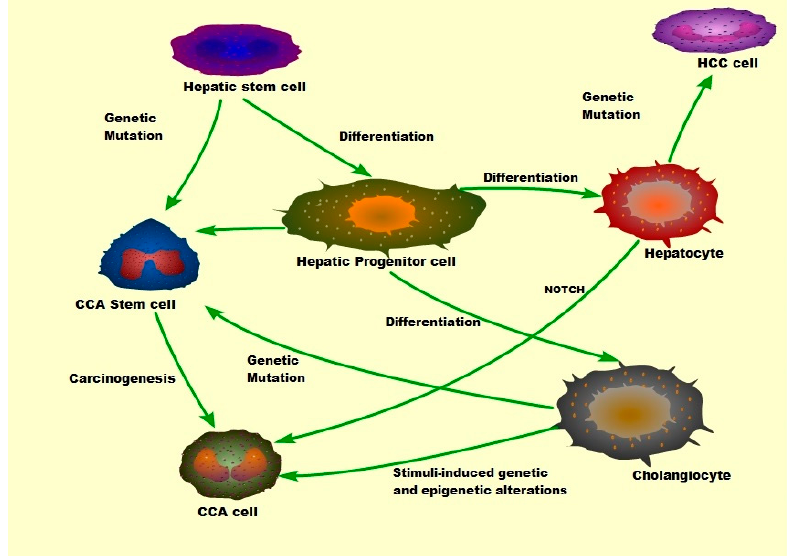
Figure 2. The hierarchy of cholangiocarcinoma stem cells . Hepatic stem cells grow and differentiate into hepatic progenitor cells and mature hepatocytes (hepatocytes and cholangiocytes). CCA stem cells are produced by genetic abnormalities of hepatic stem cells, hepatic progenitor cells, or CCA cells, which then grow and differentiate to CCA cells. The NOTCH signaling pathway might induce mature hepatocytes to develop into CCA (in mice). Cholangiocytes can also transform into CCA cells through ROS and inflammation-induced genetic and epigenetic variation.